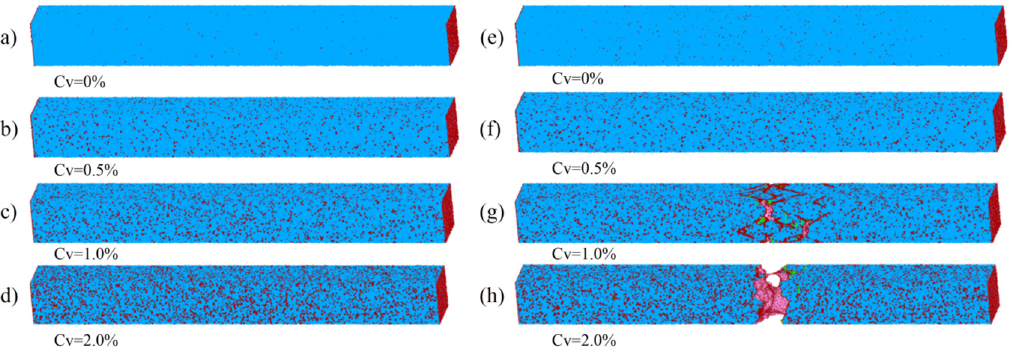
Figure 3. Atomic configurations for single-crystal magnesium with C v = 0%, 0.5%, 1.0%, and 2.0% during shock compression ( a – d ) at 20 ps and during tension ( e – h ) at 60 ps impacted along the [0001] direction under V p = 0.5 km/s. Atoms are colored by CNA values, red atoms correspond to vacancies as well as disordered atoms, blue and yellow atoms correspond to the HCP structure and BCC structure, respectively, while the green atoms correspond to stacking faults (FCC structure), and the pink atoms represent the surface of void (the following atomic colors represent the same structure).